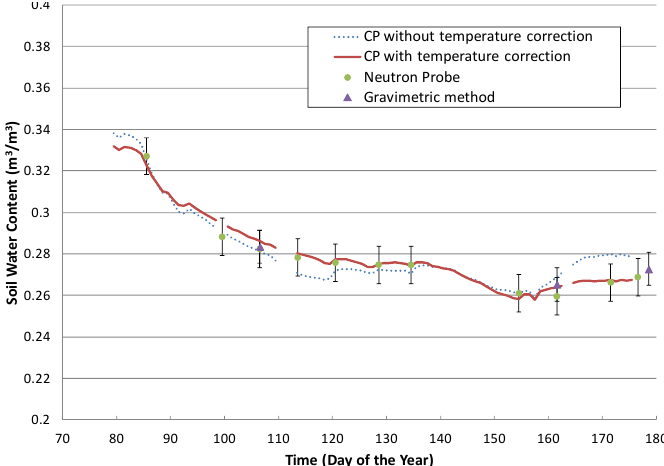
Figure 9. Soil water content measured by a HMS 9000 capacitance probe located at a 65-cm depth and by Neutron and gravimetric methods. Temperature coefficient α was determined by the Cd method. Error bars corresponds to the standard deviation of the measurements.